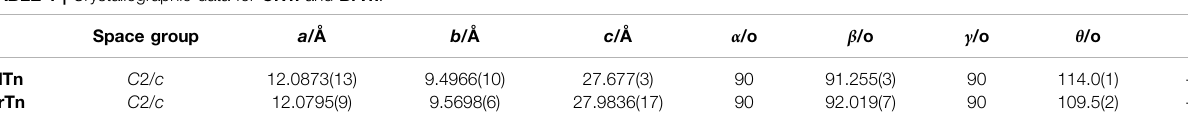
Frontiers in Chemistry |